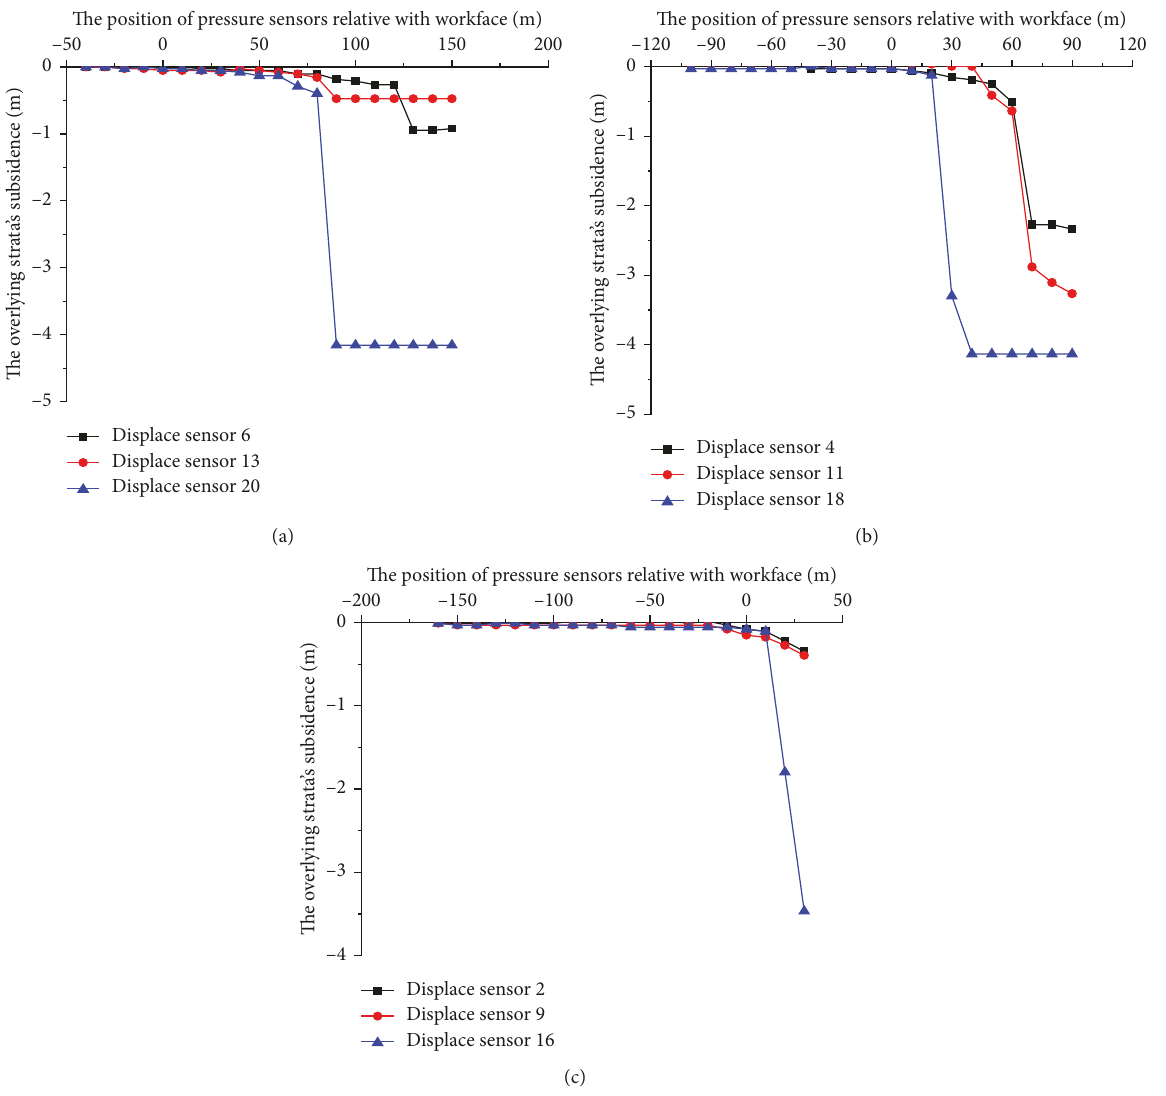
Figure 5: The overlying strata’s subsidence at some position during excavation. Displace sensor (a) 6, 13, and 20, (b) 4, 11, and 18, and (c) 2, 9, and